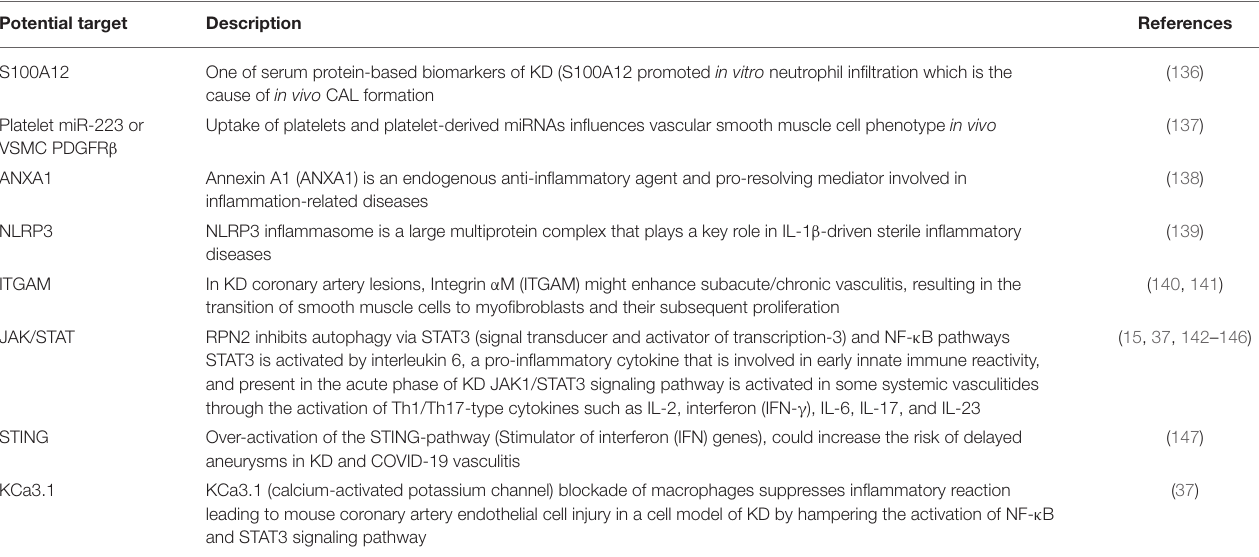
TABLE 3 | Potential therapeutic target for Kawasaki disease. Potential